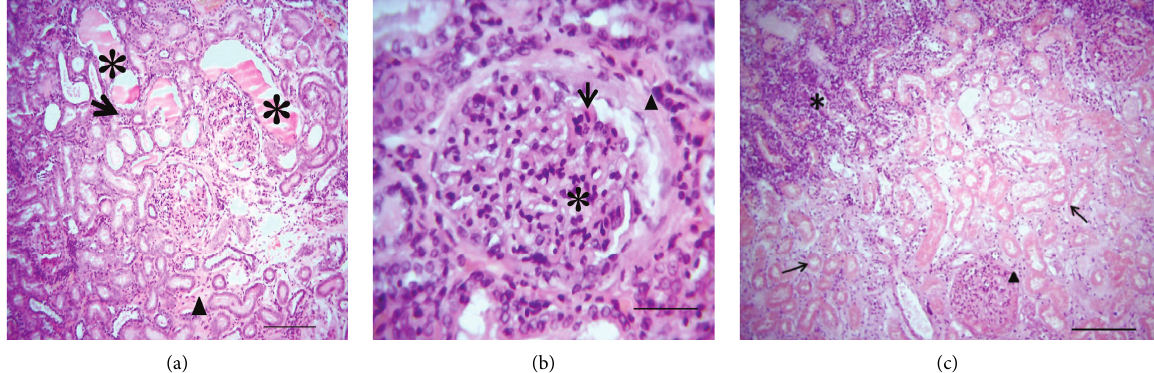
Figure 6: Histologic sections of the kidney of a Leishmania -positive dog with suspected membranoproliferative glomerulonephritis. (a) Mild interstitial fibrosis (arrowhead), as well as infiltration by mononuclear cells (arrow). Lumen of renal tubules filled with eosinophilic pro- teinaceous casts (asterisk), H&E, bar � 200 µ m. (b) Hypercellular glomerulus (asterisk), thickening of glomerular basement membrane (arrow), fibrotic outer Bowman’s capsule (arrowhead), H&E, bar � 70 µ m. (c) Margins of a renal infarct (asterisk). Coagulative necrosis of tubules (arrows) and glomeruli (asterisk), H&E, bar � 200 µ